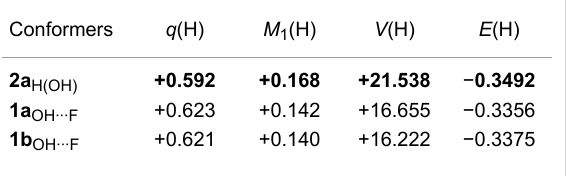
Table 3: Additional atomic properties obtained by QTAIM for hydrogen-bonding atoms (in au). Conformers